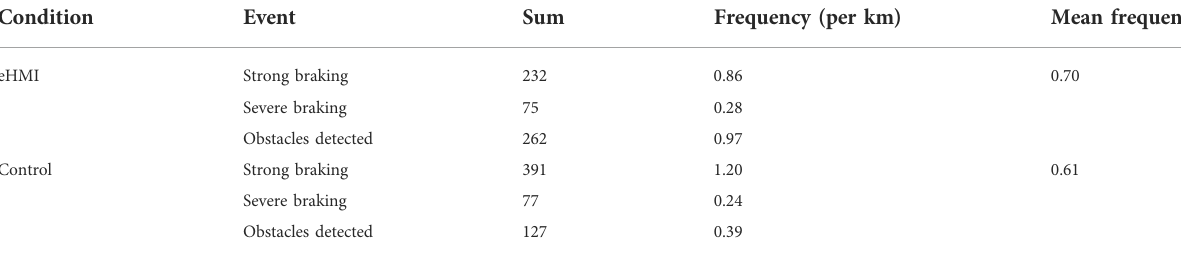
TABLE 1 Events recorded in the shuttle log across both eHMI and control